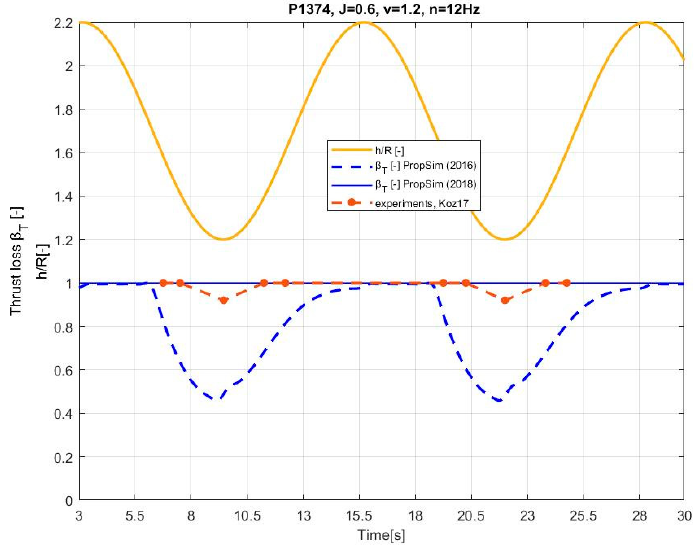
Figure 4. Comparison of thrust loss between the simulation performed by Dalheim (PropSim(2016)) and Kozlowska (PropSim (2018)) and experimental results of Koz17 .